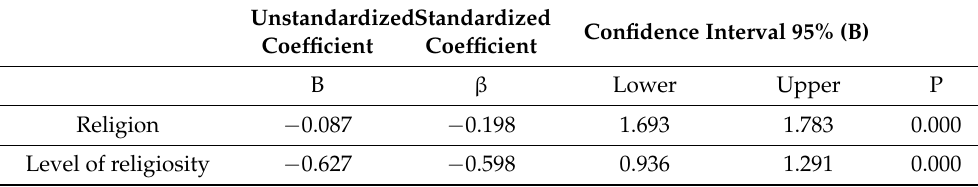
Table 5. Participants who had had penetrative sex according to sex variables and their